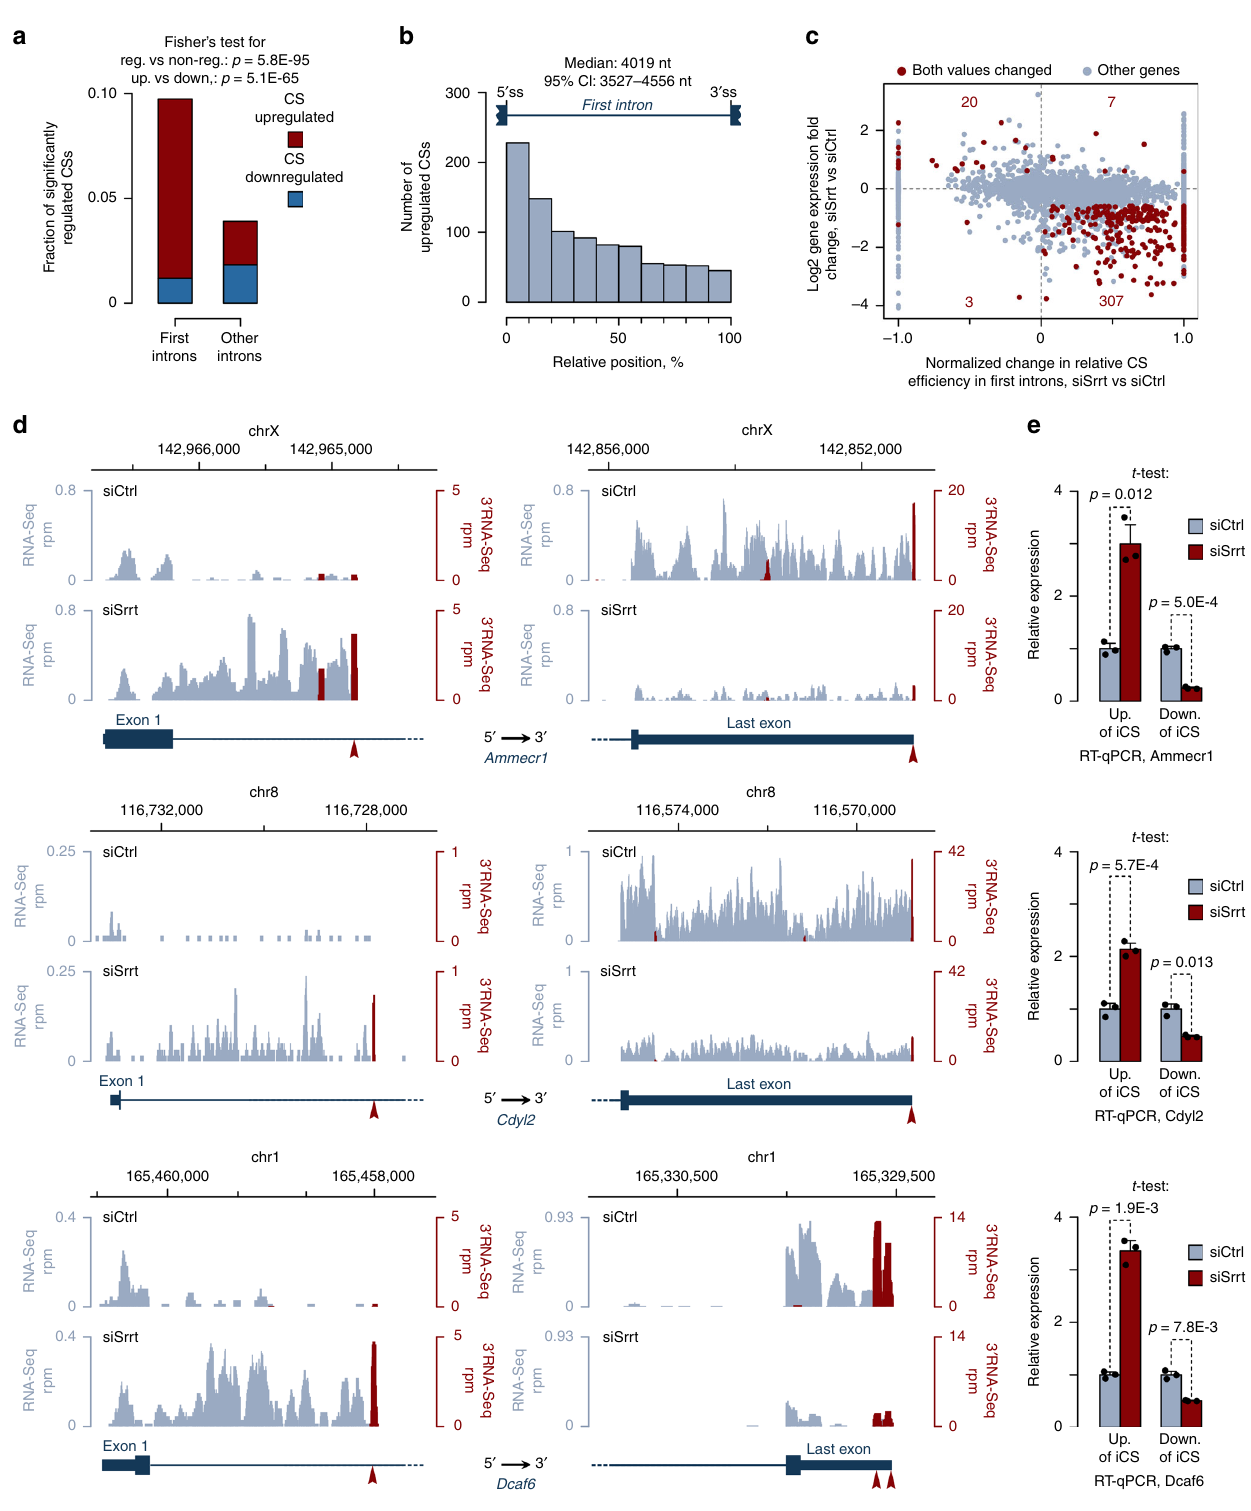
noncoding RNAs 10,14,16 , we turned to published RNA-Seq data for Dicer1/Dicer KO in mouse ESCs with a validated effect on microRNA activity 49 . The gene expression changes induced by Srrt knockdown and Dicer1 KO showed no global correlation (Supplementary Fig. 9a) and the expression of Srrt-regulated genes did not generally change in response to Dicer1 KO (Supplementary Fig. 9b). Moreover, inspection of RNA-Seq coverage pro fi les for individual Srrt targets showed no evidence for iCS regulation